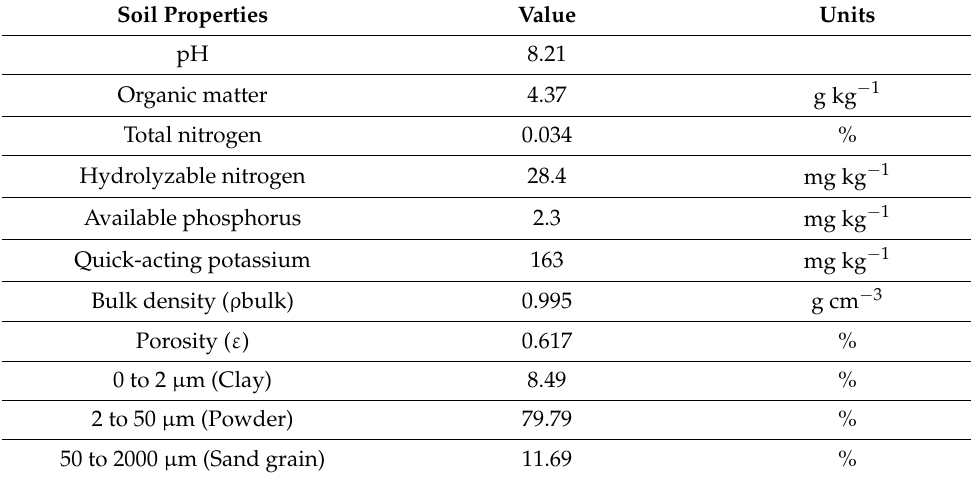
Table 1. Soil’s basic physical and chemical parameters in the experiment